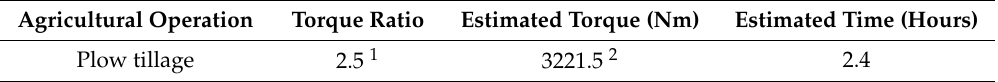
Table 4. Estimated torque and workable time for electric AWD tractor according to torque ratio of